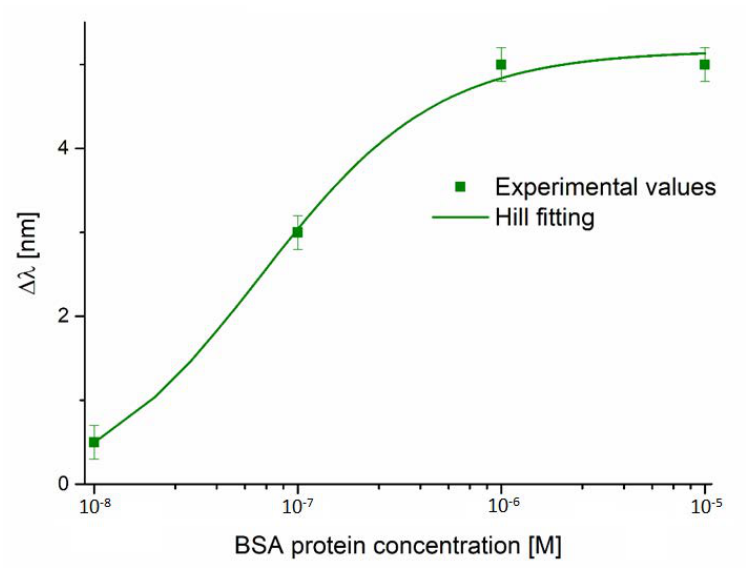
Figure 4. Resonance wavelength variation ( ∆ λ ) with respect to the blank versus the concentration of BSA protein, with the Hill fitting of the experimental values and the error bars, in a semi-log scale. Table 1 reports the parameters relative to Equation (1) for the analyzed configuration.